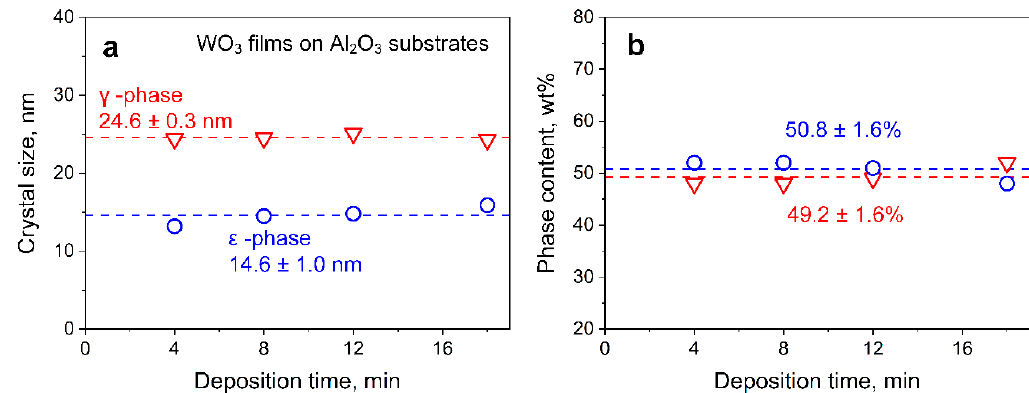
Figure 3. Effect of deposition time on WO 3 composition. ( a ) Crystal sizes and ( b ) phase content for γ - (triangles) and ε -WO 3 (circles) films on Al 2 O 3 substrates (Figure S5) with comparable crystal size and phase composition to filter-collected WO 3 powders. These films were prepared at identical deposition times to those on microsensor substrates that were too small and had too little mass for XRD. The films on Al 2 O 3 were thicker and grew faster (Figure S6) than those on microsensor substrates due to the masking of the latter. Even for these on Al 2 O 3 , no reliable XRD evaluation could be obtained for 1 and 2 min deposition due to their weak WO 3 signal.